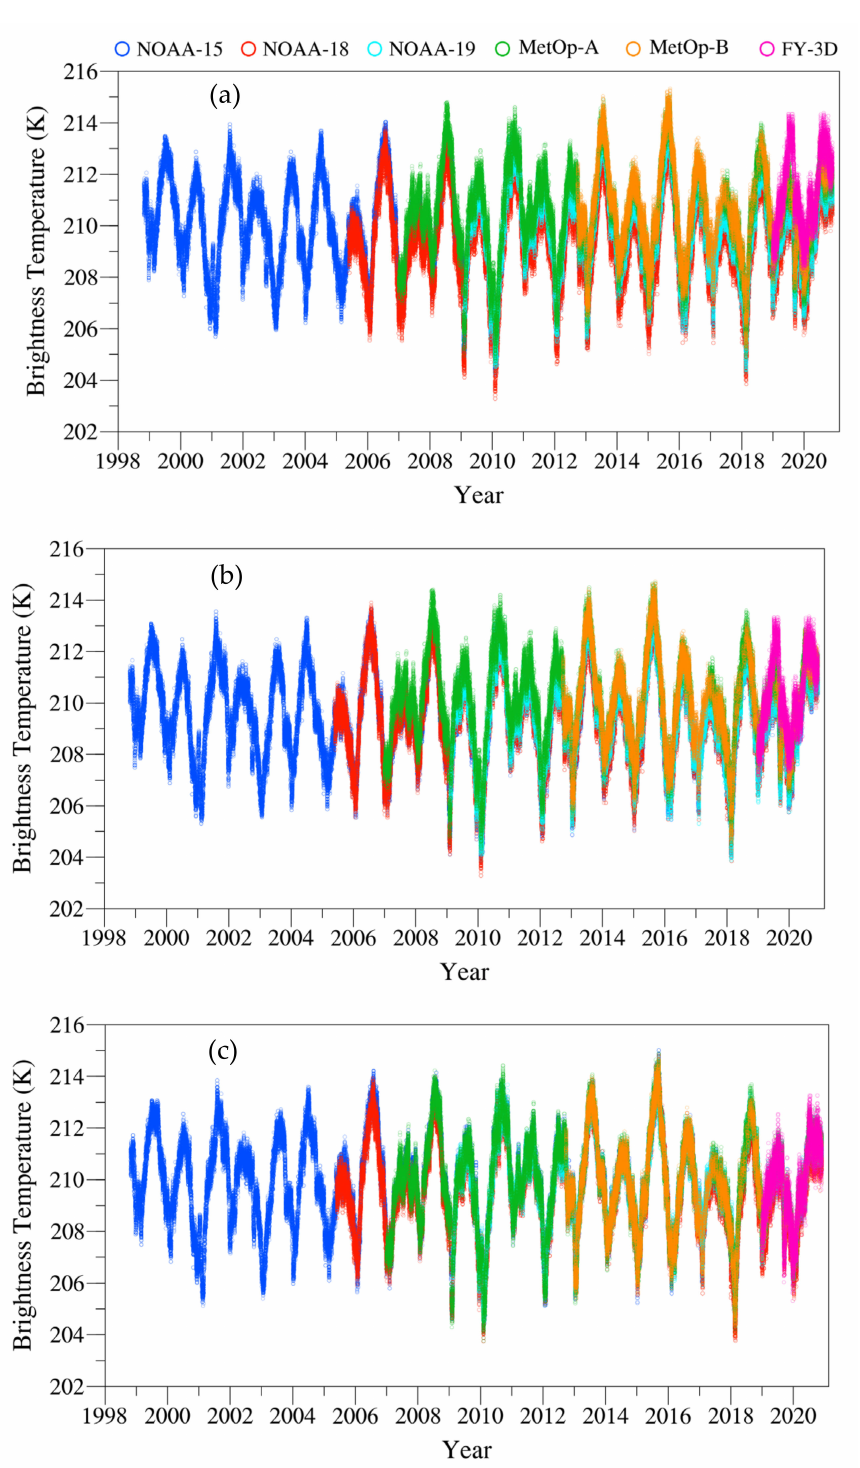
Figure 11. Same as Figure 10 except for channel 10 of ( a ) without any correction, ( b ) after inter-sensor bias correction, and ( c ) after inter-decadal diurnal